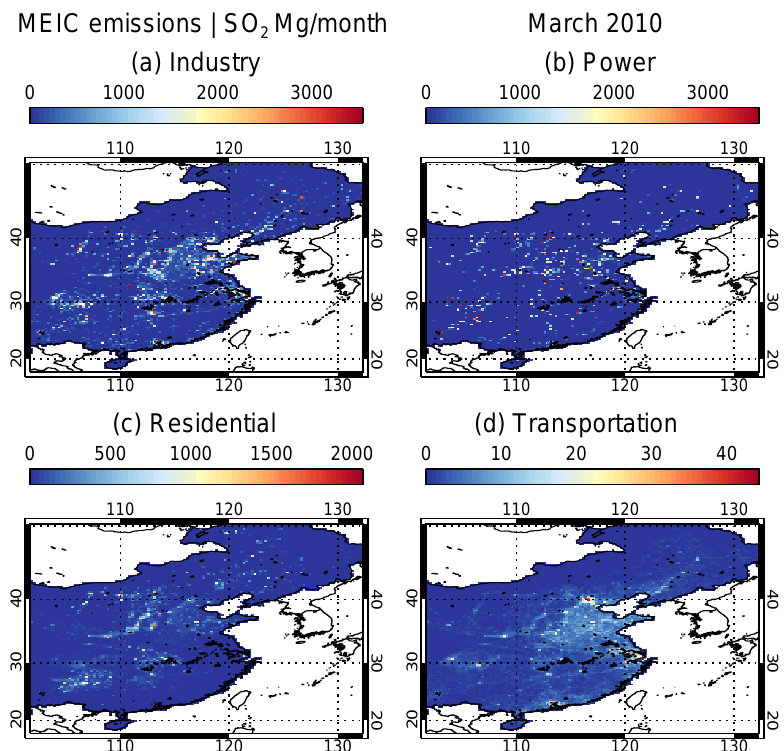
Figure 1. The SO 2 MEIC v1.2 emissions in megagrams per month for March 2010. The relative strength of the four sectors is shown here: industry (a) , power (b) , residential (c) and transportation (d) . Note the different colour bars